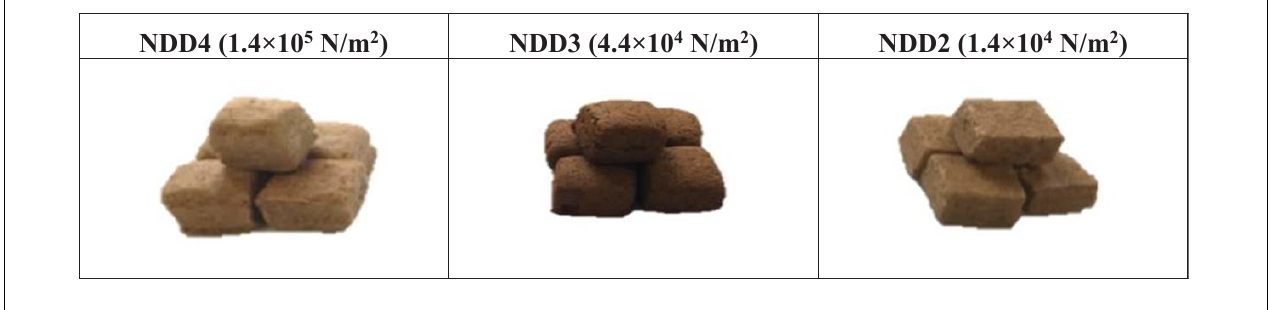
FIGURE 1 | Different textures of cookie.